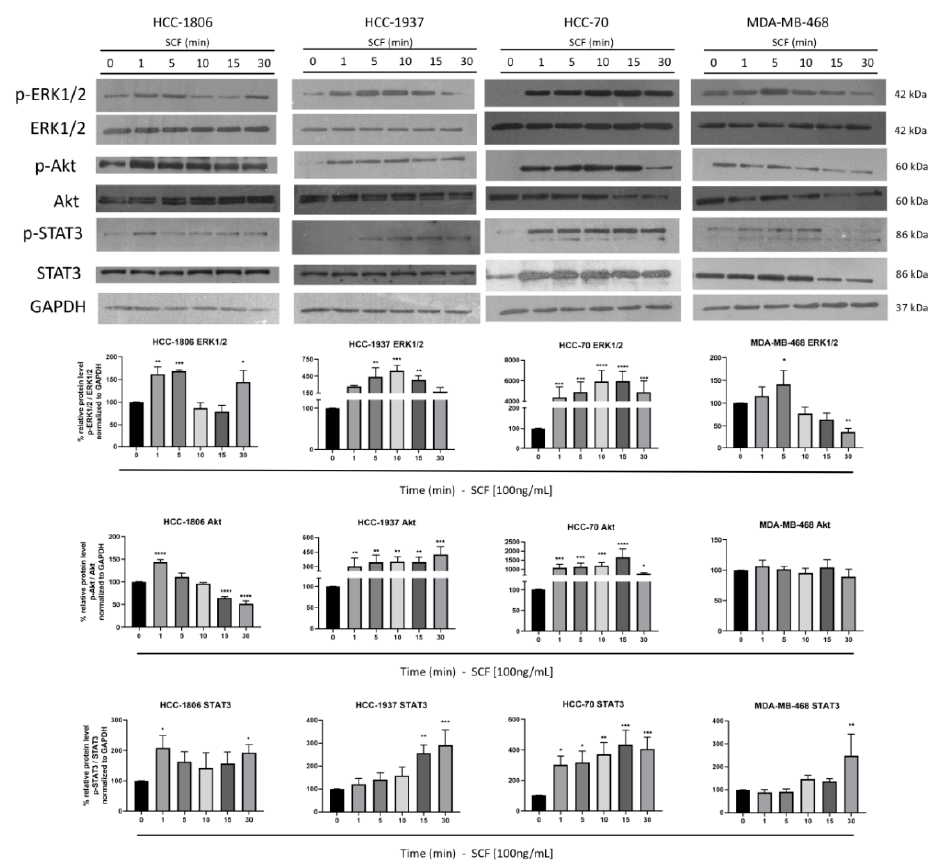
Figure 3. The effect of c-Kit activation on cell signaling cascades. HCC-1806, HCC-1937, HCC-70, and MDA-MB-468 cells were incubated with 100 ng/mL SCF for the indicated time points. Protein lysates were analyzed by 10% SDS-PAGE. Phosphorylation of clue proteins was detected using specific antibodies to p-ERK1/2, ERK1/2, p-Akt, Akt, p-STAT3, and STAT3. The detection of GAPDH was included as a control. Representative blots from triplicate experiments are shown. Densitometric analysis, indicated as percentage, is shown below the blots. The values represent the average of three independent experiments. Error bars indicate the standard error of the mean. * p < 0.05, ** p < 0.005, *** p < 0.0005, and **** p < 0.0001 vs. values that were obtained at time 0 (Dunnett test).